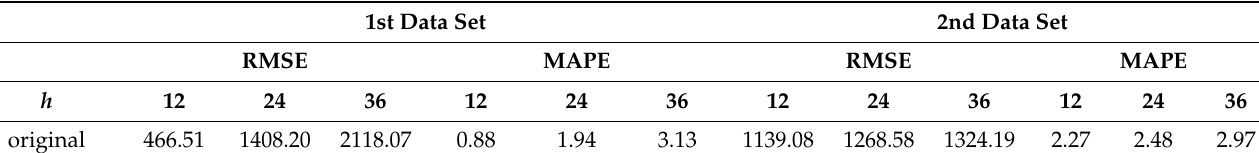
Table 3. RMSE and MAPE of h -step ahead forecast obtained by SARIMA model from the original series, KM.N and SSA.KM.N bootstrap